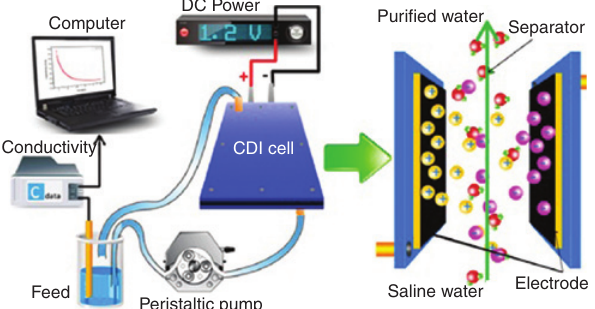
Figure 18: Schematic of the CDI setup. For details, see Ref. [83]; reprinted with permission from Elsevier.